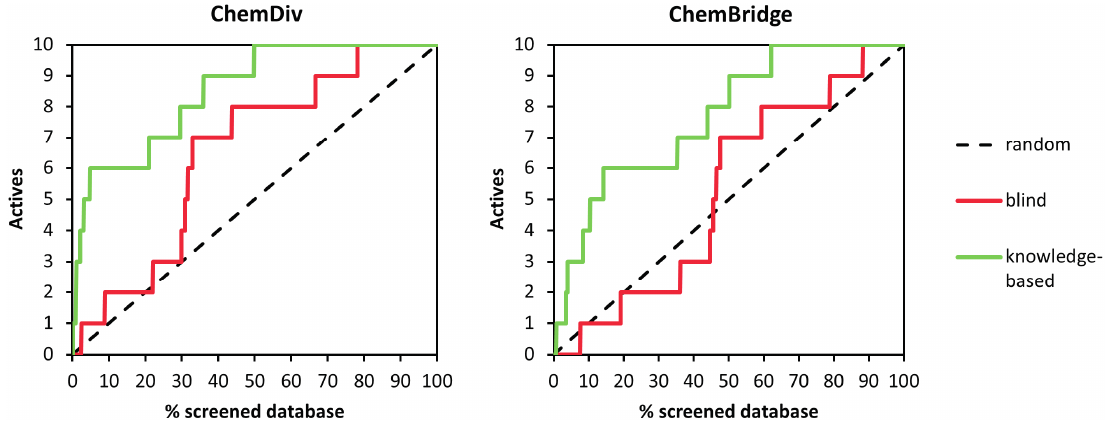
Figure 10. Enrichment curves obtained from docking simulations performed on ChemDiv ( left ) and Chembridge ( right )